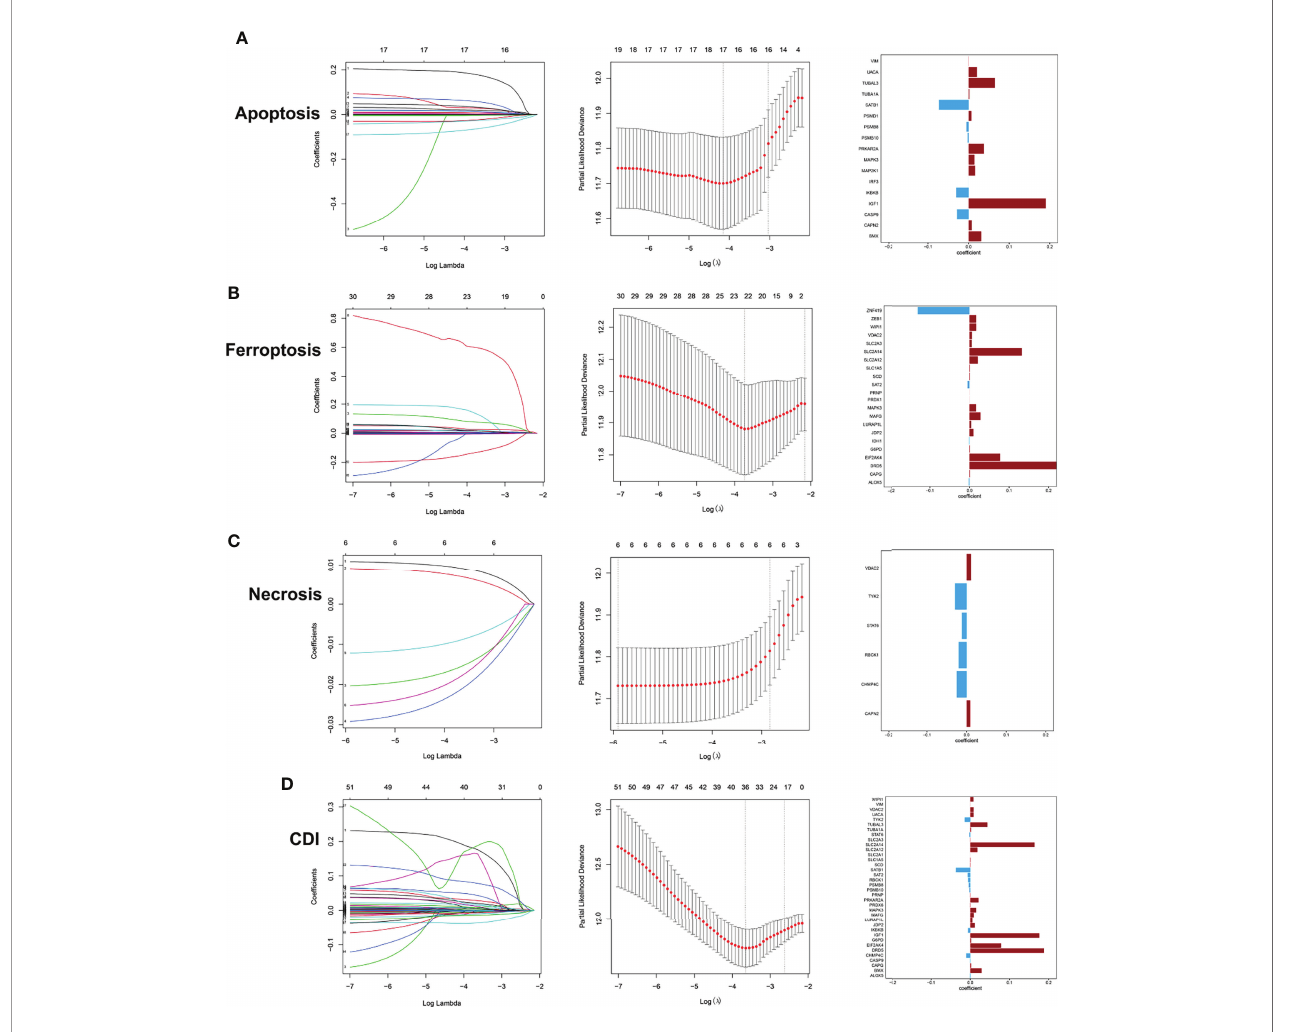
FIGURE 2 | Development of prediction models using LASSO regression analysis with pro fi les from apoptosis (A) , ferroptosis (B) , necrosis (C) , and CDI (D)